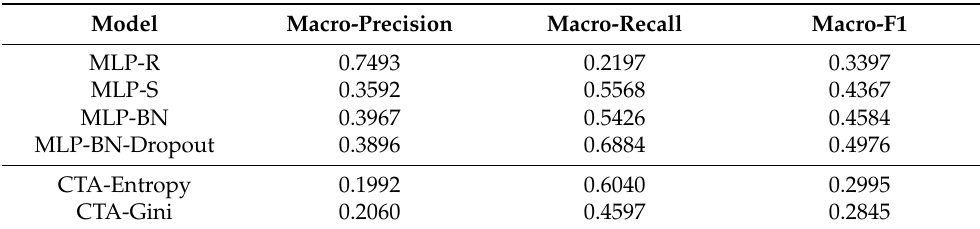
Table 2. Classification results of six models on the test data set. Model Macro-Precision